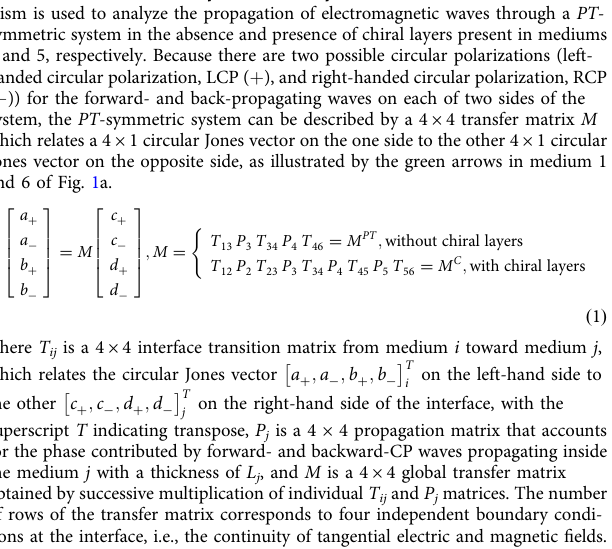
a thickness of L j = z j + 1 − z j , j = {2,3,4,5}. For visibility, the chiral layer with a thickness of L c = L 2 = L 5 = 50 nm and an average refractive index of n c = 1.33 + 10 − 4 i is chosen and represented by gray shaded areas. Chirality-dependent Δ α ( z 6 ) is denoted by blue downward and red upward